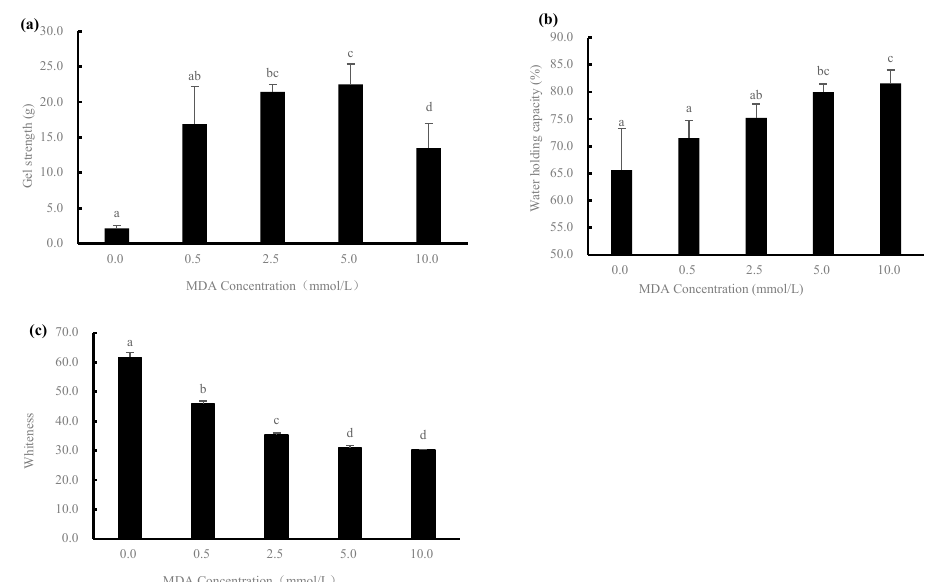
Figure 4. Changes in gel strength ( a ), water holding capacity ( b ), and whiteness ( c ) of duck myofibrillar proteins treated with different malondialdehyde (MDA) concentrations (0, 0.5, 2.5, 5.0, and 10.0 mmol/L). Different letters ( a – d ) indicate significant difference ( p < 0.05). Similar to gel strength, analysis of the water holding capacity of gels can also reflect the quality of differently treated myofibrillar protein gels. The water holding capacity of